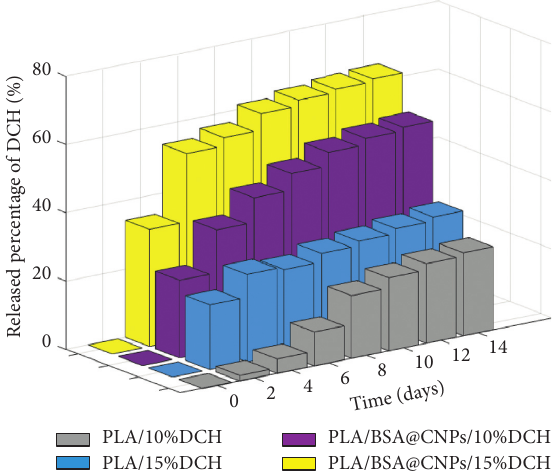
Figure 4: Release behavior of doxycycline.